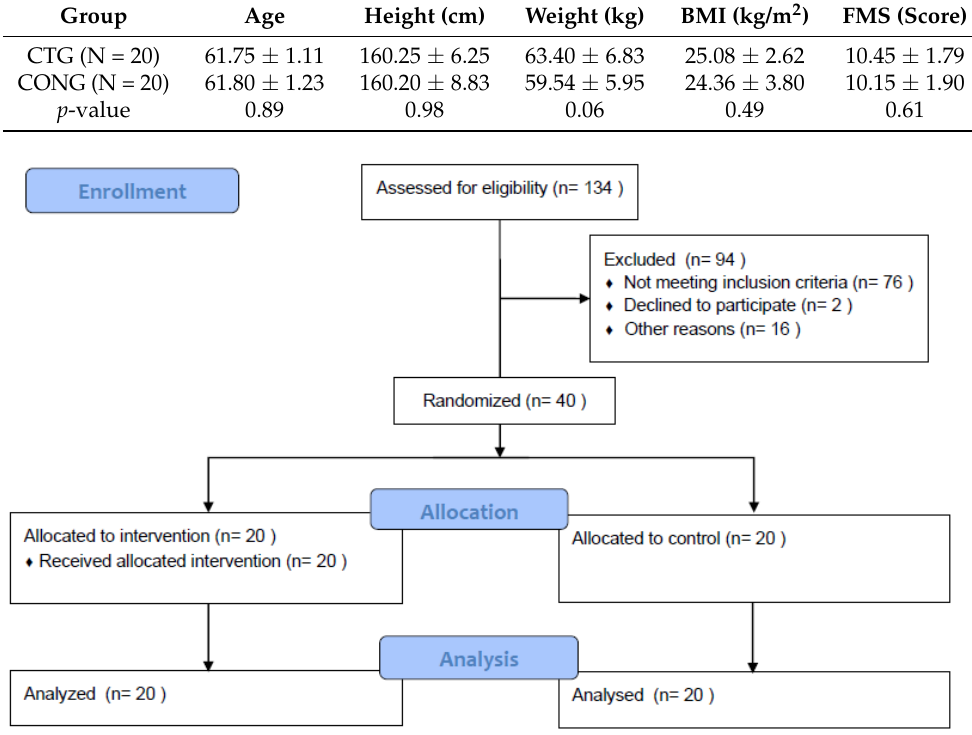
Table 1. Basic information of experimental subjects.